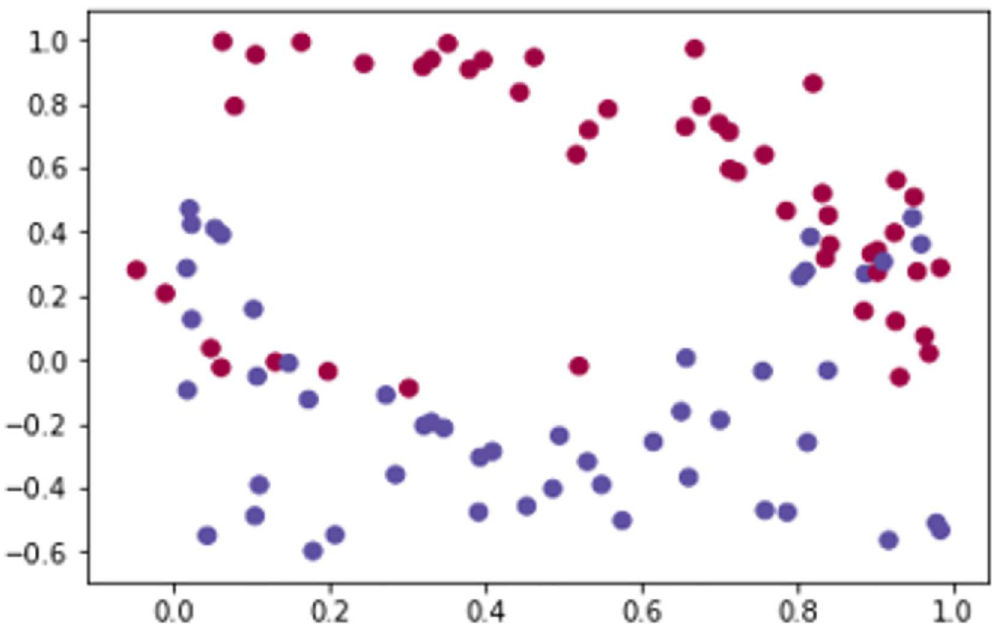
Fig 36. Binary sentiment polarity distribution of